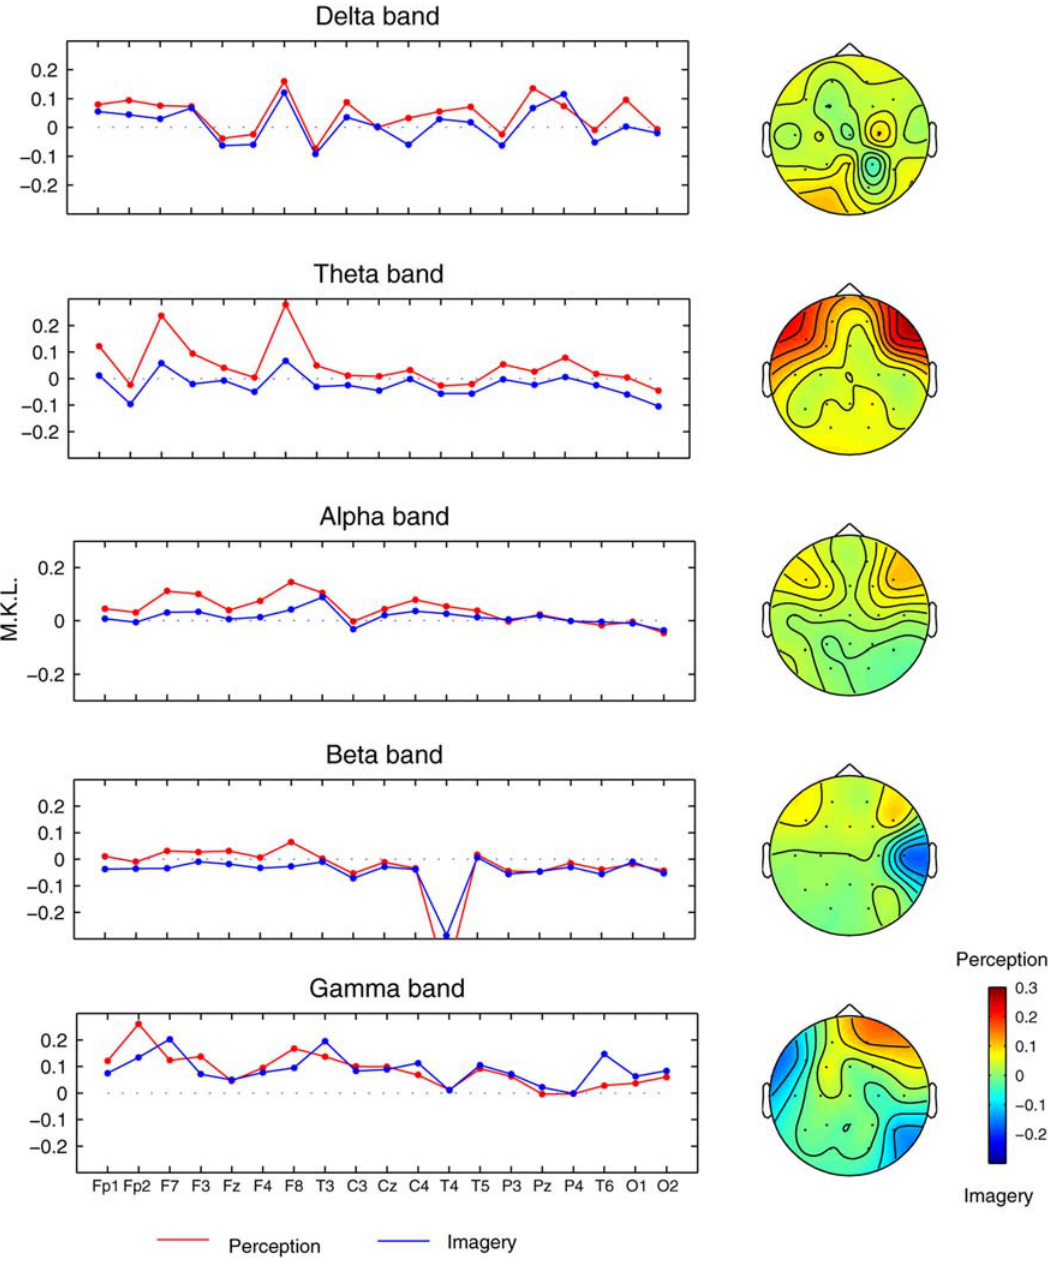
Figure 3. Universality across brain regions at different frequency bands for all participants. Mean Kullback Leibler (MKL) divergence measure for five different scales ( a =32, 18, 10, 5, and 2) used in the wavelet transform which roughly correspond to five standard frequency bands: delta ( , 4 Hz), theta (5–8 Hz), alpha (9–12 Hz), beta (13–30 Hz), and gamma ( . 30 Hz). Results were pooled across groups, participants, electrode